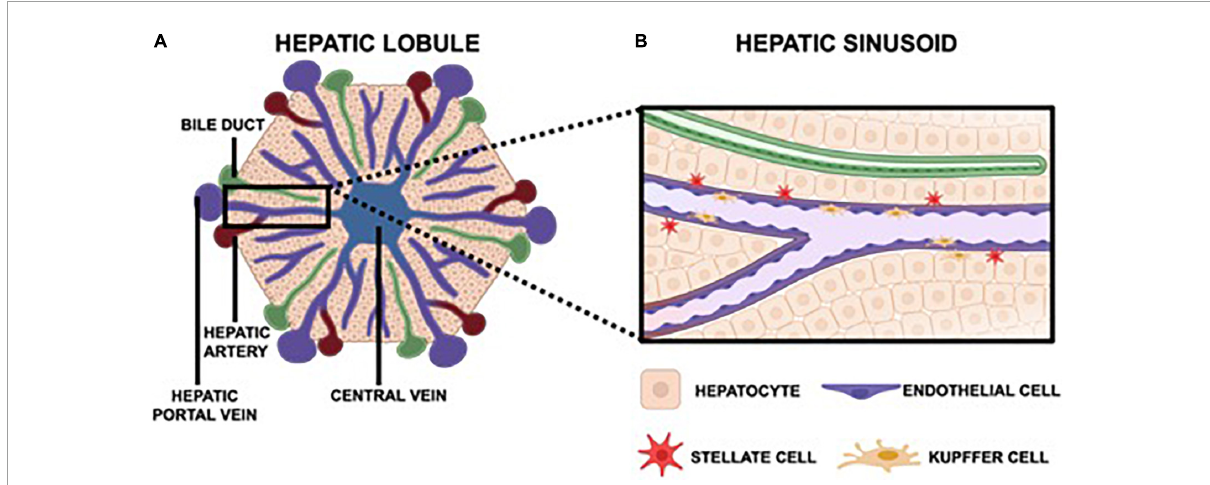
FIGURE1 The hepatic lobule is hexagonal, functional unit of the liver that features six portal triads. Each portal triad is comprised of a bile duct, a hepatic portal vein, and a hepatic artery (A) . The hepatic portal vein and hepatic artery converge to form the hepatic sinusoid, which carries blood toward the central vein that then returns to the heart. Each sinusoid is lined with endothelial cells and surrounded by hepatocytes, the parenchymal cells of the liver. Also native to the sinusoid are Kupffer cells, the resident macrophages, and stellate cells, which are quiescent in a healthy liver but instigate a fibrotic response in an inflammatory microenvironment (B)